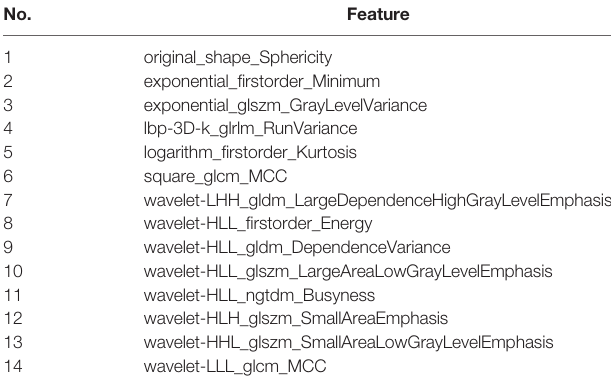
TABLE 3 | Radiomics Screening Features.